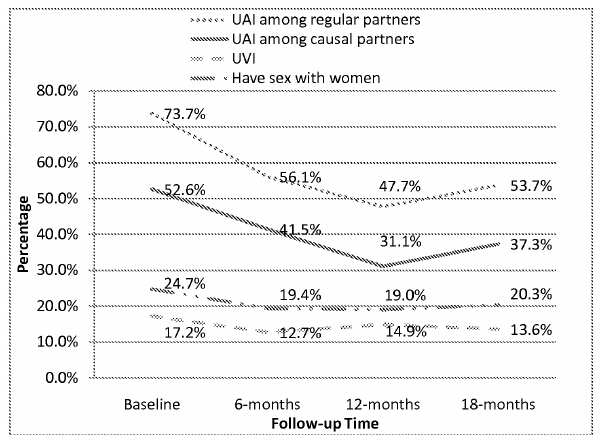
Figure 3. The trend of UAI among regular and casual partners and UVI with women. This figure indicates the trend of high-risk behaviors among regular and casual partners, and the percentage who also would have had sex with women. The greatest decreases in risk behaviors were observed between baseline and the initial six months.